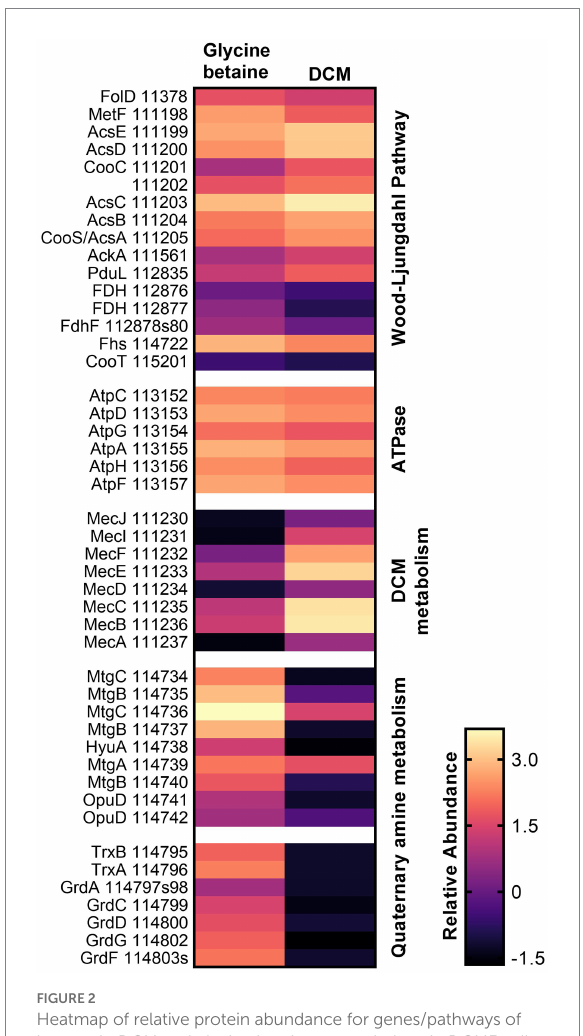
FIGURE 2 Heatmap of relative protein abundance for genes/pathways of interest in DCM and glycine betaine-amended strain DCMF cells. Proteins for the Wood–Ljungdahl pathway and a F O F 1 -type ATPase were highly abundant under both growth conditions, while proteins in the DCM-associated mec cassette were significantly more abundant in DCM-grown cells, and proteins in a putative glycine betaine methyltransferase gene cluster and a sarcosine reductase gene cluster were significantly more abundant in glycine betaine-grown cells. Rows are labeled with gene symbols and the strain DCMF IMG gene loci (each prefaced with